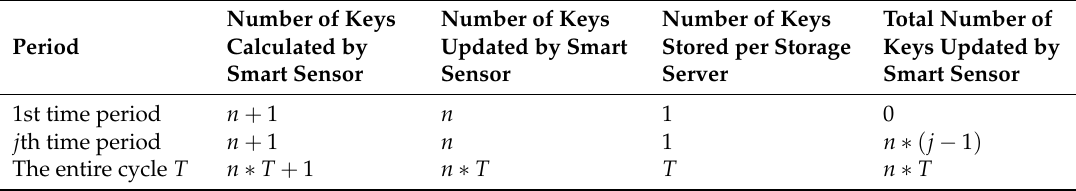
Table 3. Solution cost